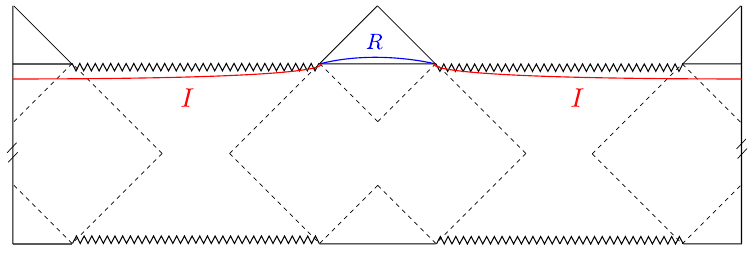
Figure 4. The “purity” saddle which gives S = 0 for the entropy of one of the two hats in an n = 2